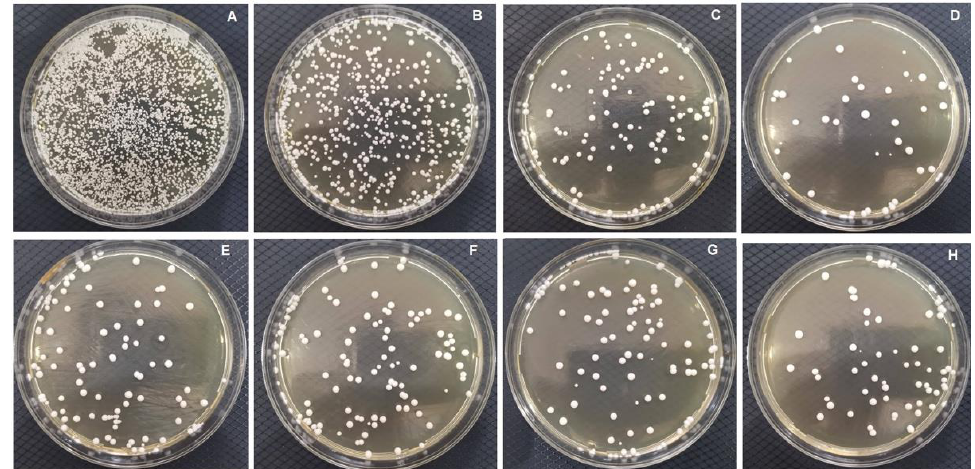
Figure 5. Candida count according TiO 2 nanoparticle % and layering technique: ( A ) Negative; ( B ) control — Unmodified; ( C ) one-layer 1%; ( D ) one-layer- 2.5%; ( E ) double-layer 1%; ( F ) double-layer 2.5%; ( G ) dotted-layer 1% groups; and ( H ) dotted-layer 2.5% groups.